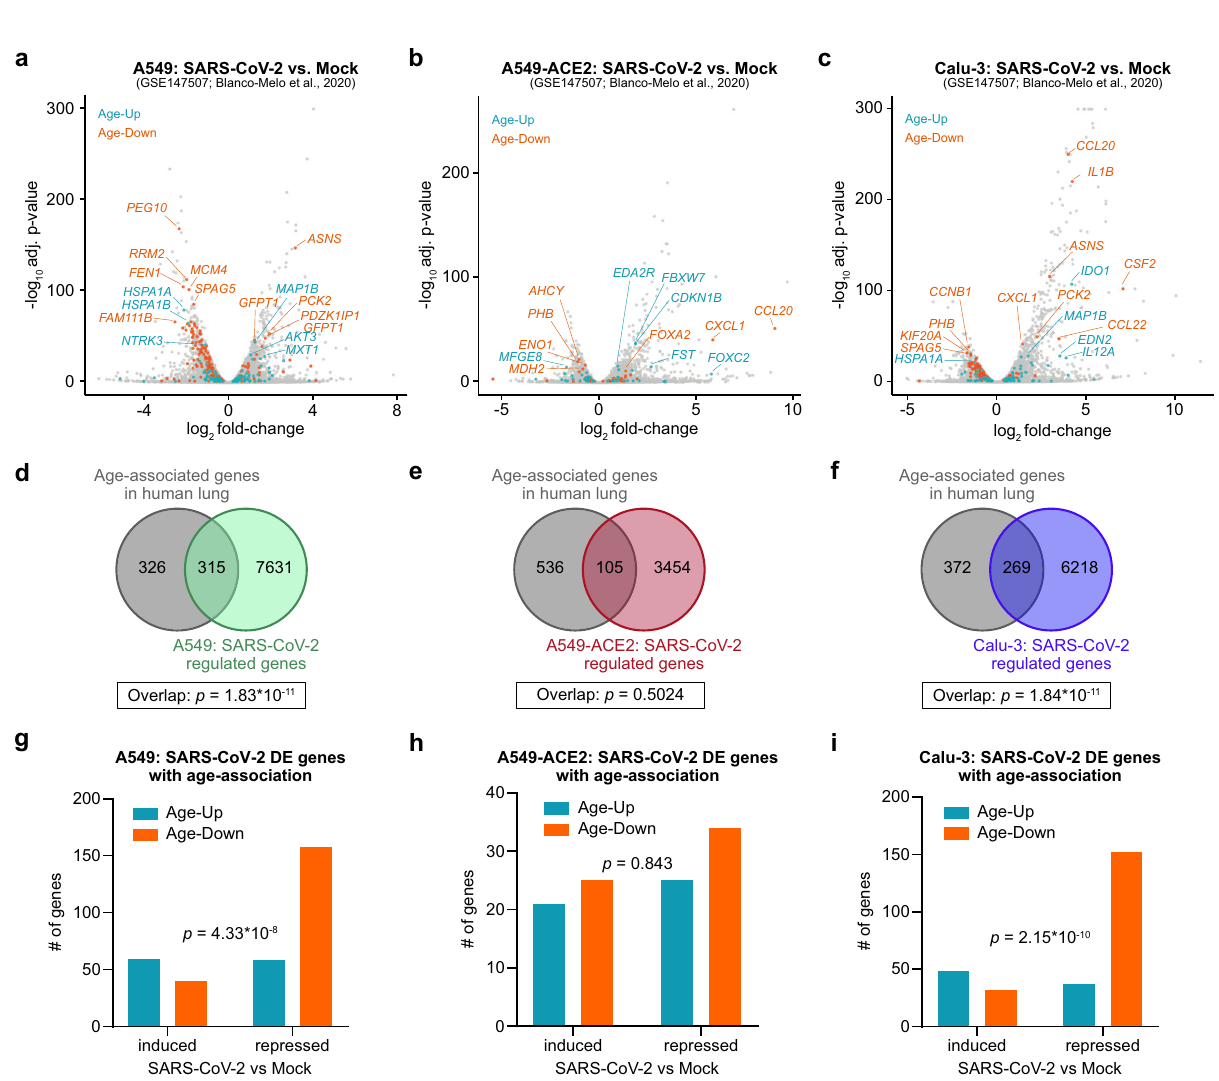
Fig. 5 SARS-CoV-2 infection alters the expression of lung age-associated genes in vitro. a – c Volcano plots of differentially expressed genes in A549 cells ( a ), A549 cells transduced with an ACE2 vector (A549-ACE2) ( b ), or Calu-3 cells ( c ). Data are from GSE147507 77 . Age-associated genes are color- coded. d – f Venn diagrams highlighting the intersections between lung age-associated genes and SARS-CoV-2-regulated genes in A549 cells ( d ), A549- ACE2 cells ( e ), or Calu-3 cells ( f ). Statistical signi fi cance of the overlap was assessed by the hypergeometric test. g – i Characteristics of age-associated genes that are affected by SARS-CoV-2 infection in A549 cells ( g ), A549-ACE2 cells ( h ), or Calu-3 cells ( i ), from d – f . Statistical signi fi cance of the interaction between the directionality of SARS-CoV-2 regulation (induced or repressed) and the directionality of age-association (increase or decrease with age) was assessed by two-tailed Fisher ’ s exact